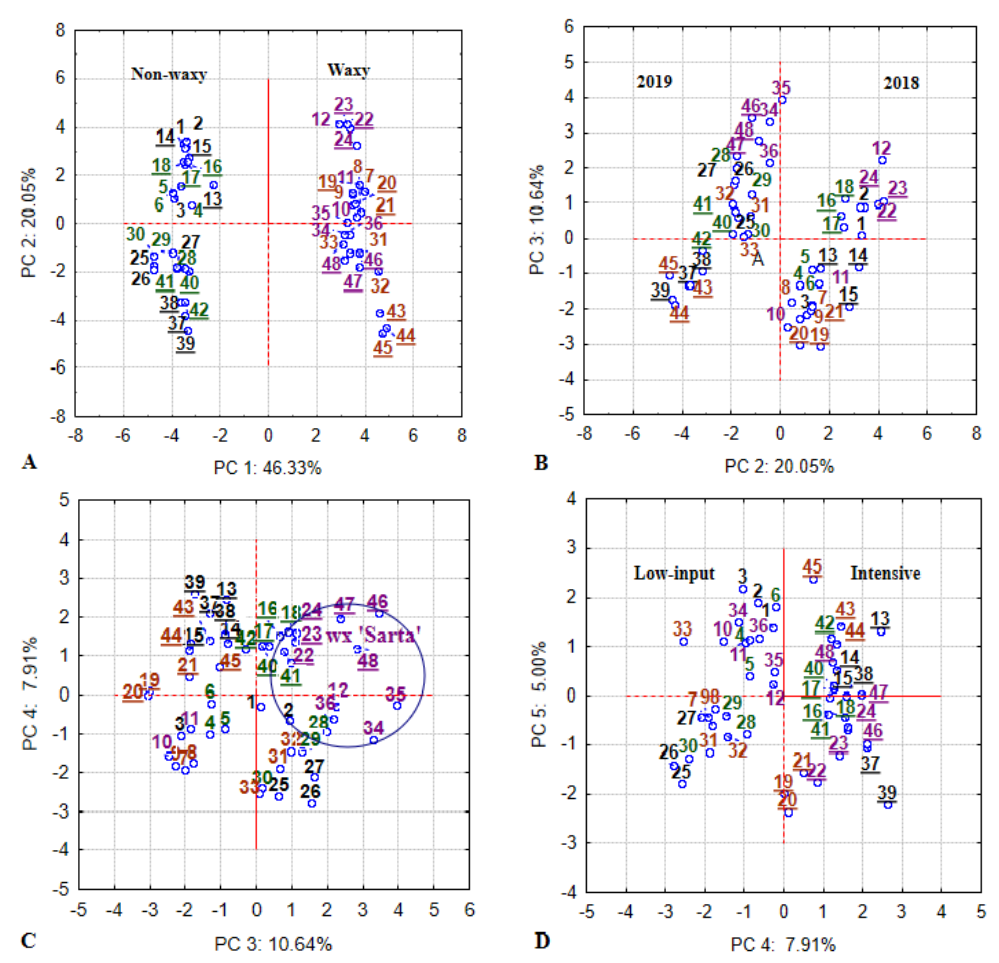
Figure 6. Loading plots from principal components analysis (PCA): PC1 × PC2 scores plot ( A ), PC2 × PC3 scores plot ( B ), PC3 × PC4 scores plot ( C ), PC4 × PC5 scores plot ( D ). Analysis was conducted using data of grain yield and quality characteristics when 4 winter wheat cultivars (2 non-waxy and 2 waxy) grown in low-input and intensive farming systems over 2-year conditions. Designation: black—‘Skagen’, green—‘Suleva DS’, brown—Wx ‘Eldija’, purple—Wx ‘Sarta’, not